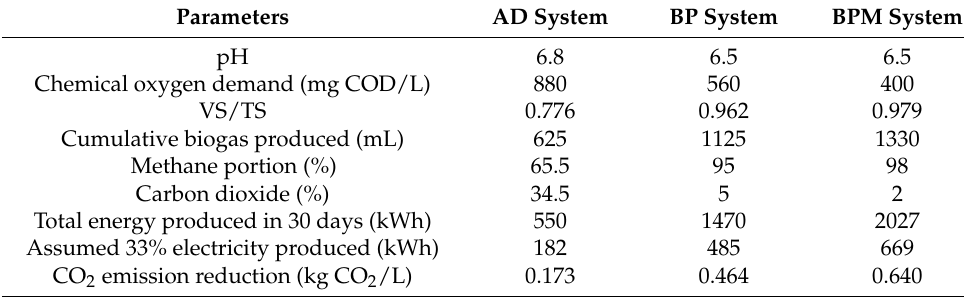
Table 2. Summary of bioreactor performance after 30 days of incubation.